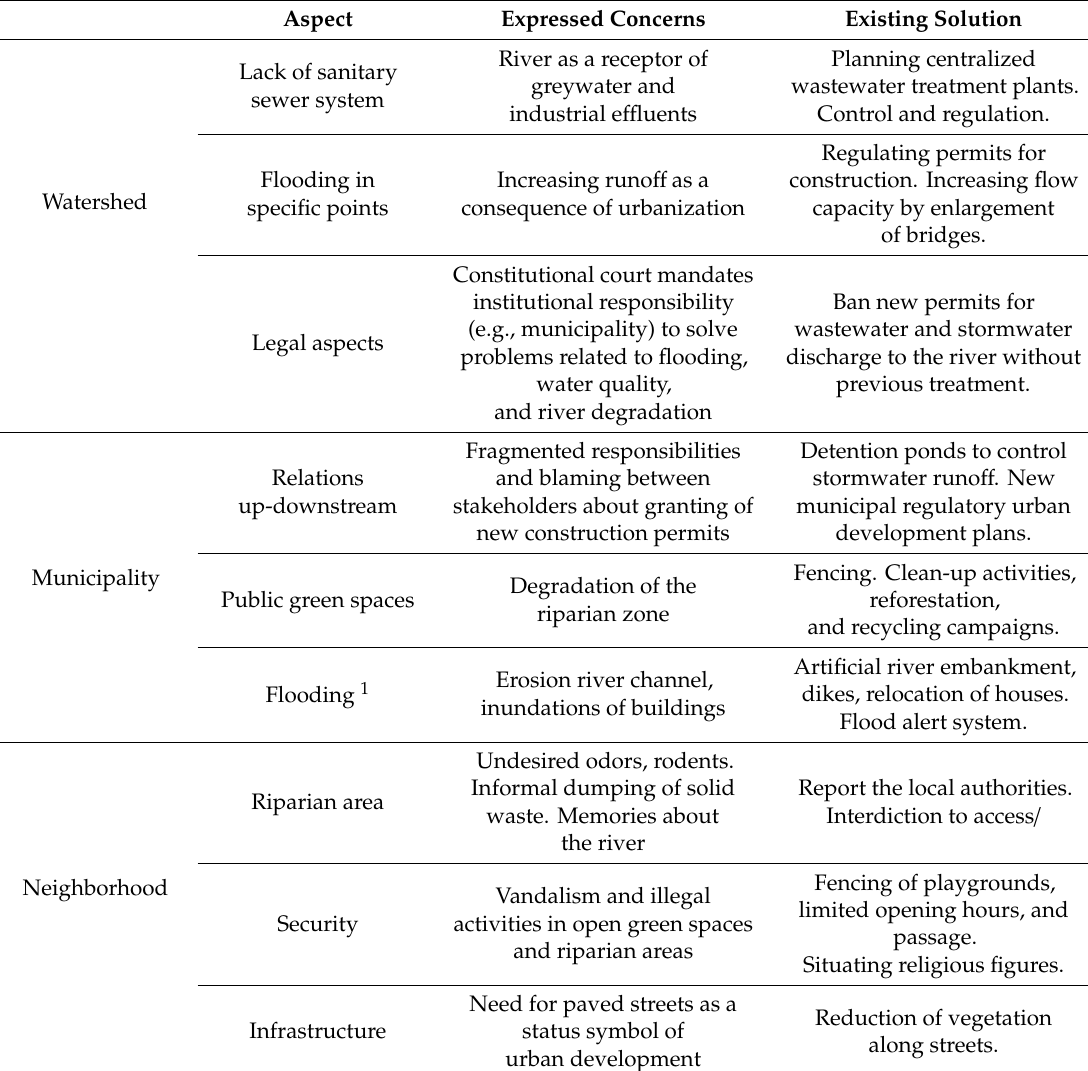
Table 2. Aspects related to the water management identified as relevant by local actors at di ff erent